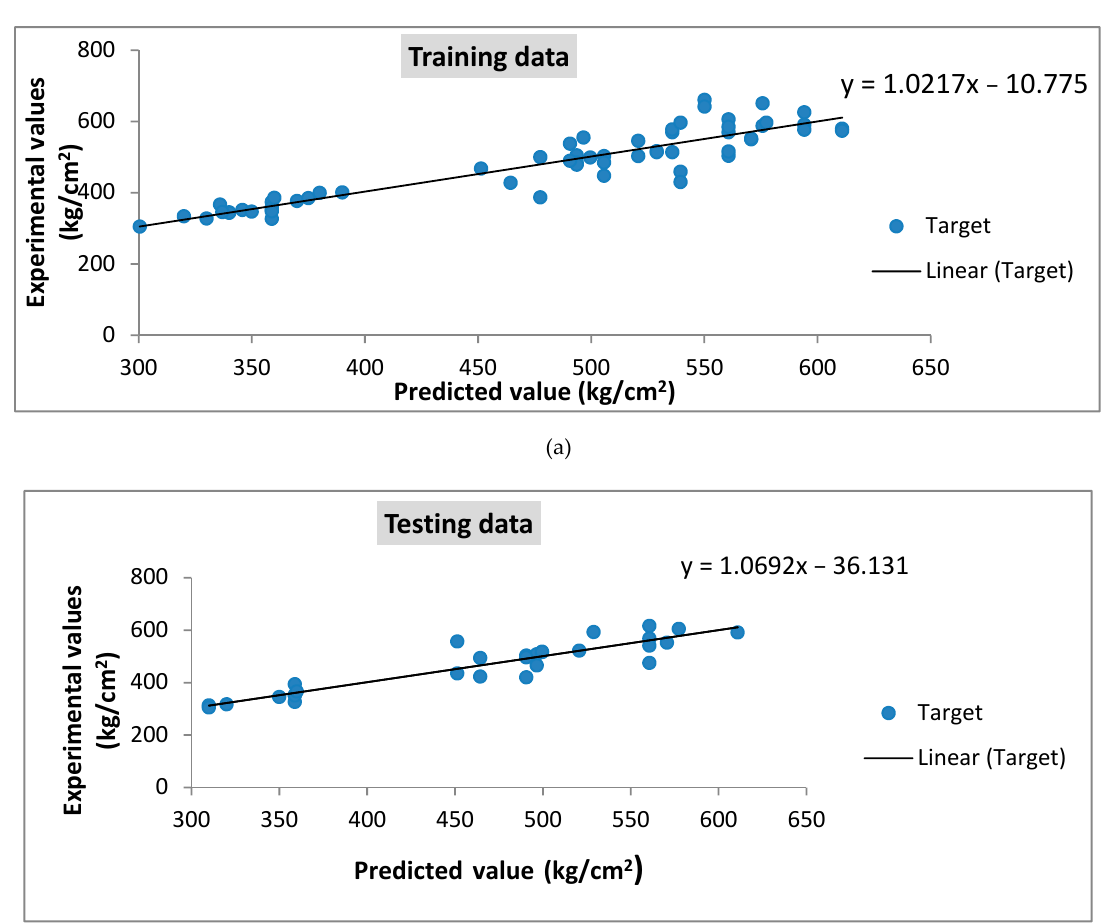
Figure 14. Regression chart for the GEP1 prediction model of compressive strength: ( a ) training data, ( b ) testing data.